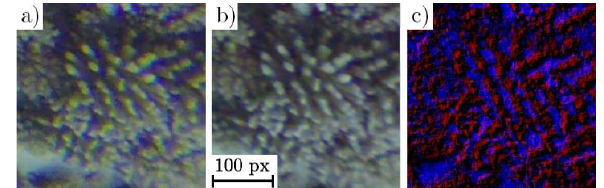
Figure 6. (a) Chromatic aberration seen near the image corner in an underwater GoPro frame. (b) Correction of the CA by relative alignment of the red and blue channel with respect to the green using the standard brown model. (c) Difference between image (a) and (b), slightly enhanced.